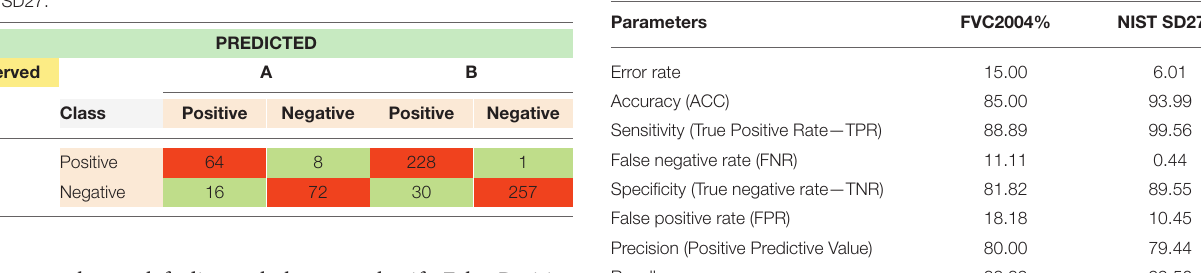
TABLE 3 | Other measures derived from the confusion matrix.